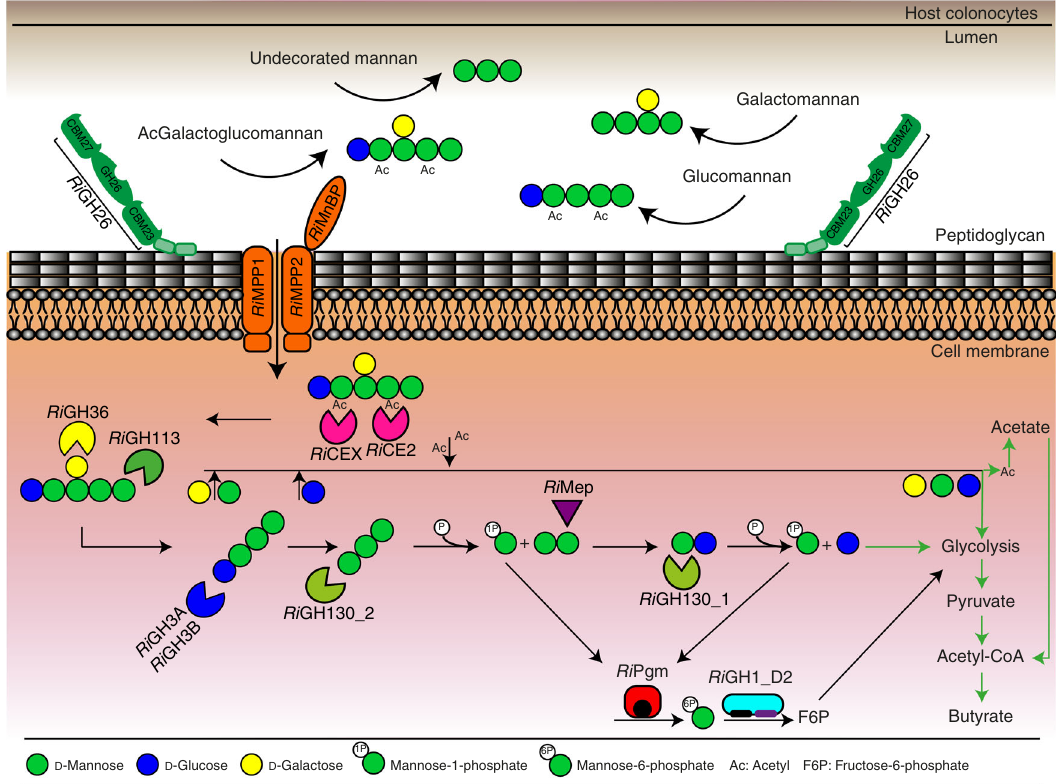
Fig. 7 Model for the degradation and utilization of complex β -mannans in R. intestinalis . Intracellular degradation of an acetylated galactoglucomanno- oligosaccharide is used as an example. Sugars are represented as in Fig. 1. Initial depolymerization of acetylated galactoglucomannan (AcGalactoglucomannan) occurs at the outer surface of R. intestinalis by the activity of Ri GH26 (green). The extracellular recruitment of β -mannan is facilitated by interactions with CBM27 and CBM23. Import of products occurs through the ABC transporter Ri MnBP/RiMPP1/RiMPP2 (orange). Within the cytoplasm, the acetyl and galactosyl decorations are removed by the two acetyl esterases Ri CE2 and Ri CEX (pink) and the α -galactosidase Ri GH36 (yellow). The two β -glucosidases Ri GH3A and Ri GH3B (blue) release glucose from the non-reducing end of the β -manno-oligosaccharide. In addition, the reducing end mannose-releasing exo-oligomannosidase Ri GH113 (green) can catalyze the removal of mannose units from the decorated manno- oligosaccharides until it reaches a galactosyl substituent at the subsite − 1. Once de-ornamented, the β -manno-oligosaccharides are sacchari fi ed by the exo-acting Ri GH130_2 (light green) with accumulation of M 2 . The M 2 undergoes subsequent epimerization and phosphorolysis by the concerted activity of Ri Mep - Ri GH130_1 (light green), with release of glucose and M1P. These end products enter the glycolytic pathway either directly (for glucose) or after being converted into M6P and F6P by the phosphomannose mutase Ri Pgm (red) and the isomerase Ri GH1_D2 (turquoise, purple domain). Released mannose is converted to M6P by a hexokinase and processed as described above. Galactose enters glycolysis after conversion to G1P via the Leloir pathway. The pyruvate generated from glycolysis is converted to acetyl-CoA and then butyrate. Black arrows show reactions demonstrated in this study. Green arrows indicate previously demonstrated steps for the generation of butyrate from monosaccharides fermentation 68 by R.